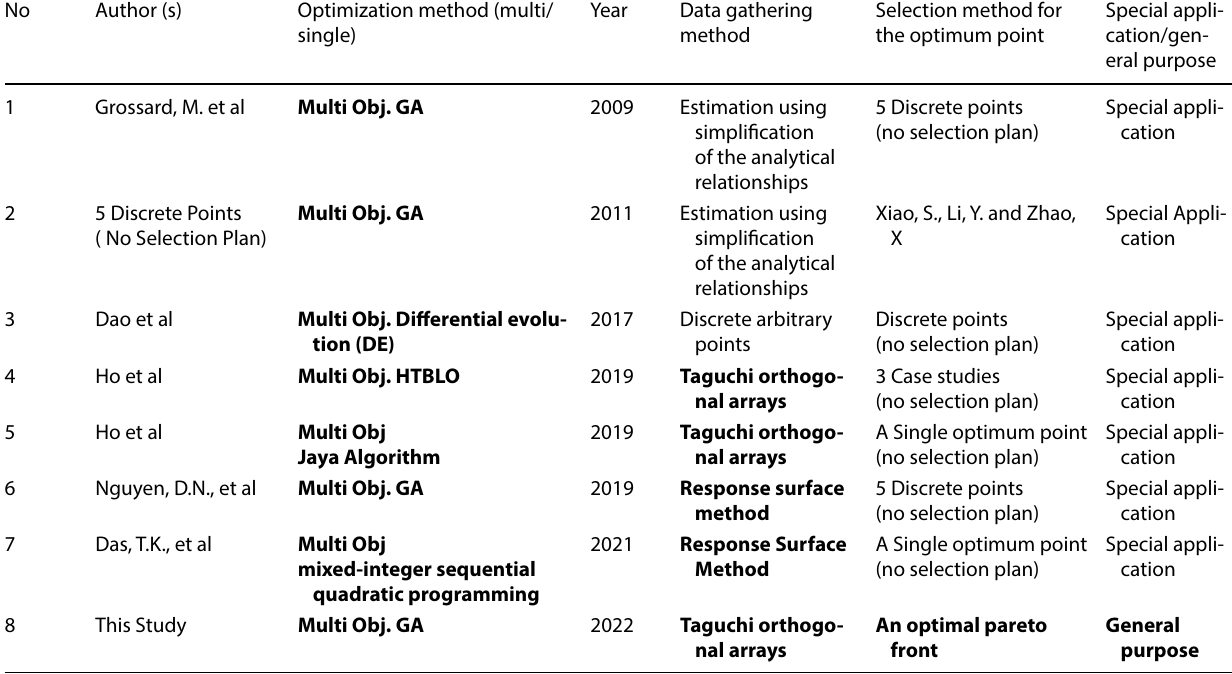
Table 16 Comparison of the proposed algorithm with previous